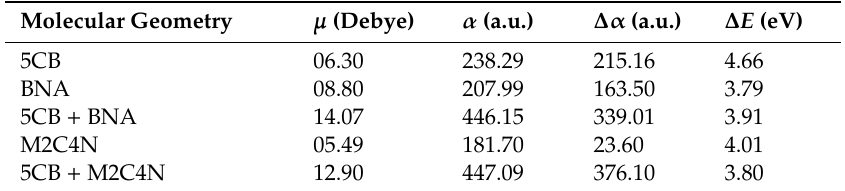
Table 2. Calculated µ , α , ∆ α , and ∆ E of 5CB, BNA, 5CB + BNA, M2C4N, and 5CB + M2C4N molecules via Gaussian 09-DFT methods.